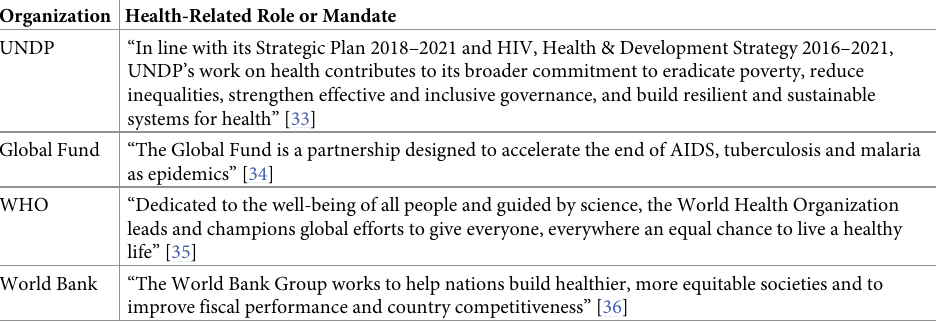
Table 1. IOs’ health-related mandates or